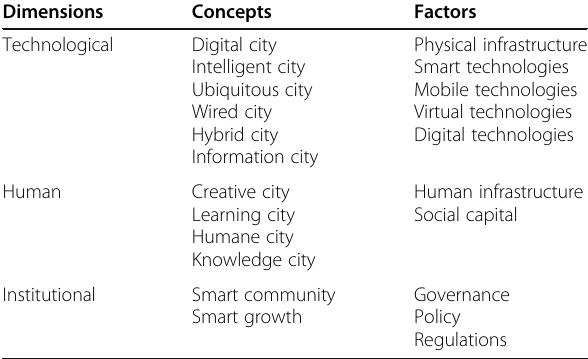
Table 1 Dimensions, concept, and factors of “ smart city ” [14]